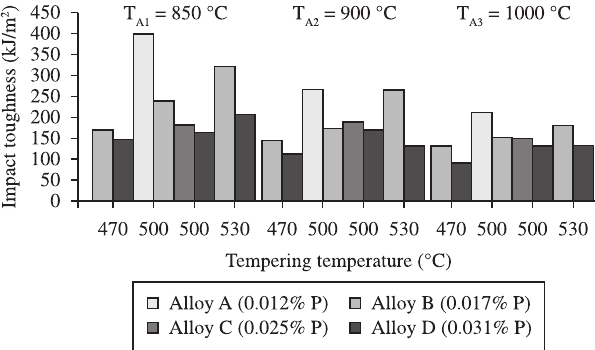
Figure 9. Absorbed energy in the Charpy impact test. Comparative image for all conditions studied in this work.